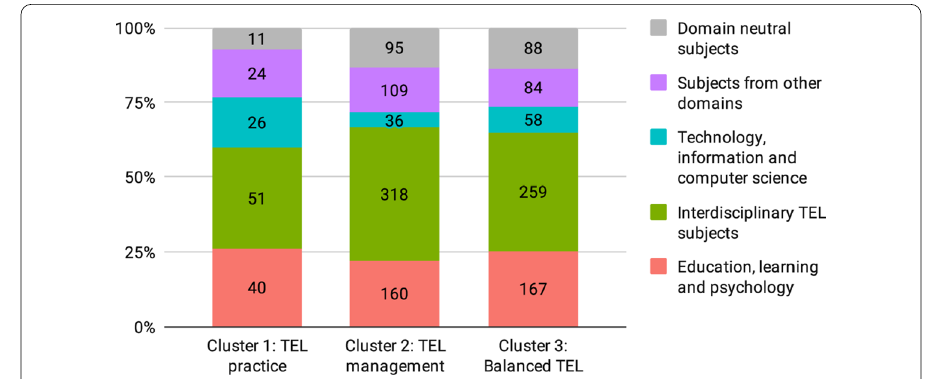
Fig. 6 Share of topic domains in the Program